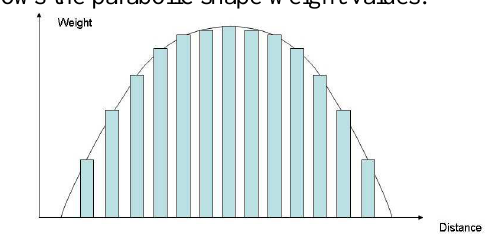
Fig. 6. The weight values of the CMMs are set to be anal- ogous to parabolic shape which describe the distance from the central